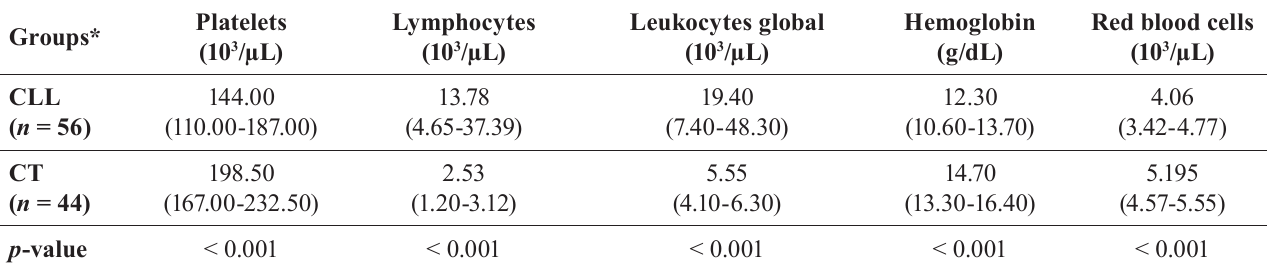
TABLE II - Blood cell analysis from patients and control subjects